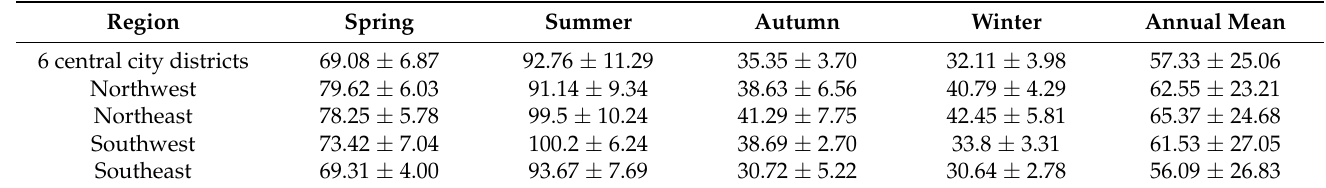
Table 2. Regional distribution of average seasonal and annual average O 3 concentrations ( μ g·m − 3 ) Region Spring